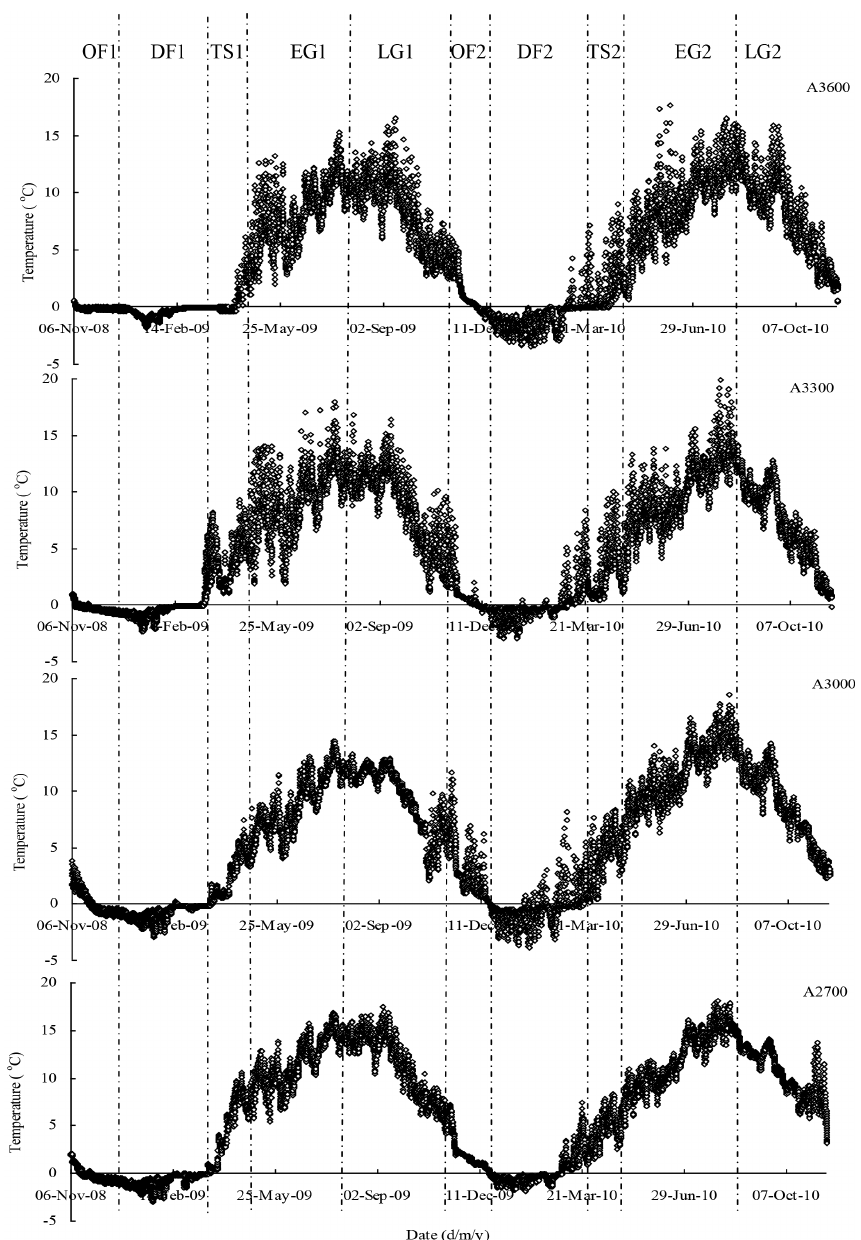
Figure 2. Graph of temperature taken at 2-hour intervals in litterbags at four sampling plots positioned at different altitudes from 6 Novem- ber 2008 to 16 November 2010. Sampling stages were partitioned from differences ascertained in freezing and thawing characteristics as temperatures changed. OF: onset of frozen stage exhibiting frequent soil temperature fluctuation around 0 ◦ C from November to December; DF: deep frozen stage at which soil temperature remains constant below 0 ◦ C from December to the following March; TP: thawing stage at which soil temperature remains close to around 0 ◦ C as temperature increases from March to April; EG: early stage of growing season at which soil temperature continuously increases from April to August; LG: later stage of growing season at which soil temperature decreases continuously from August to